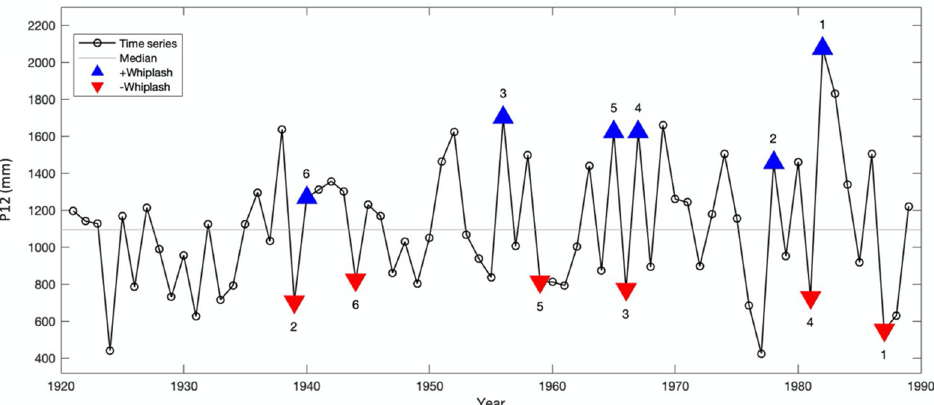
Figure 2. Time series of P12 precipitation data, 1921–1989, which is the calibration period for all reconstructions. Whiplash events are identified in the second year of the two-year whiplash event by positive (blue) and negative (red) triangles and ranked (annotated number) by the size of the precipitation anomaly in the two years, as described in the text. For example, 1982 and 1987 are the second years of the top-ranking positive and negative events, respectively.